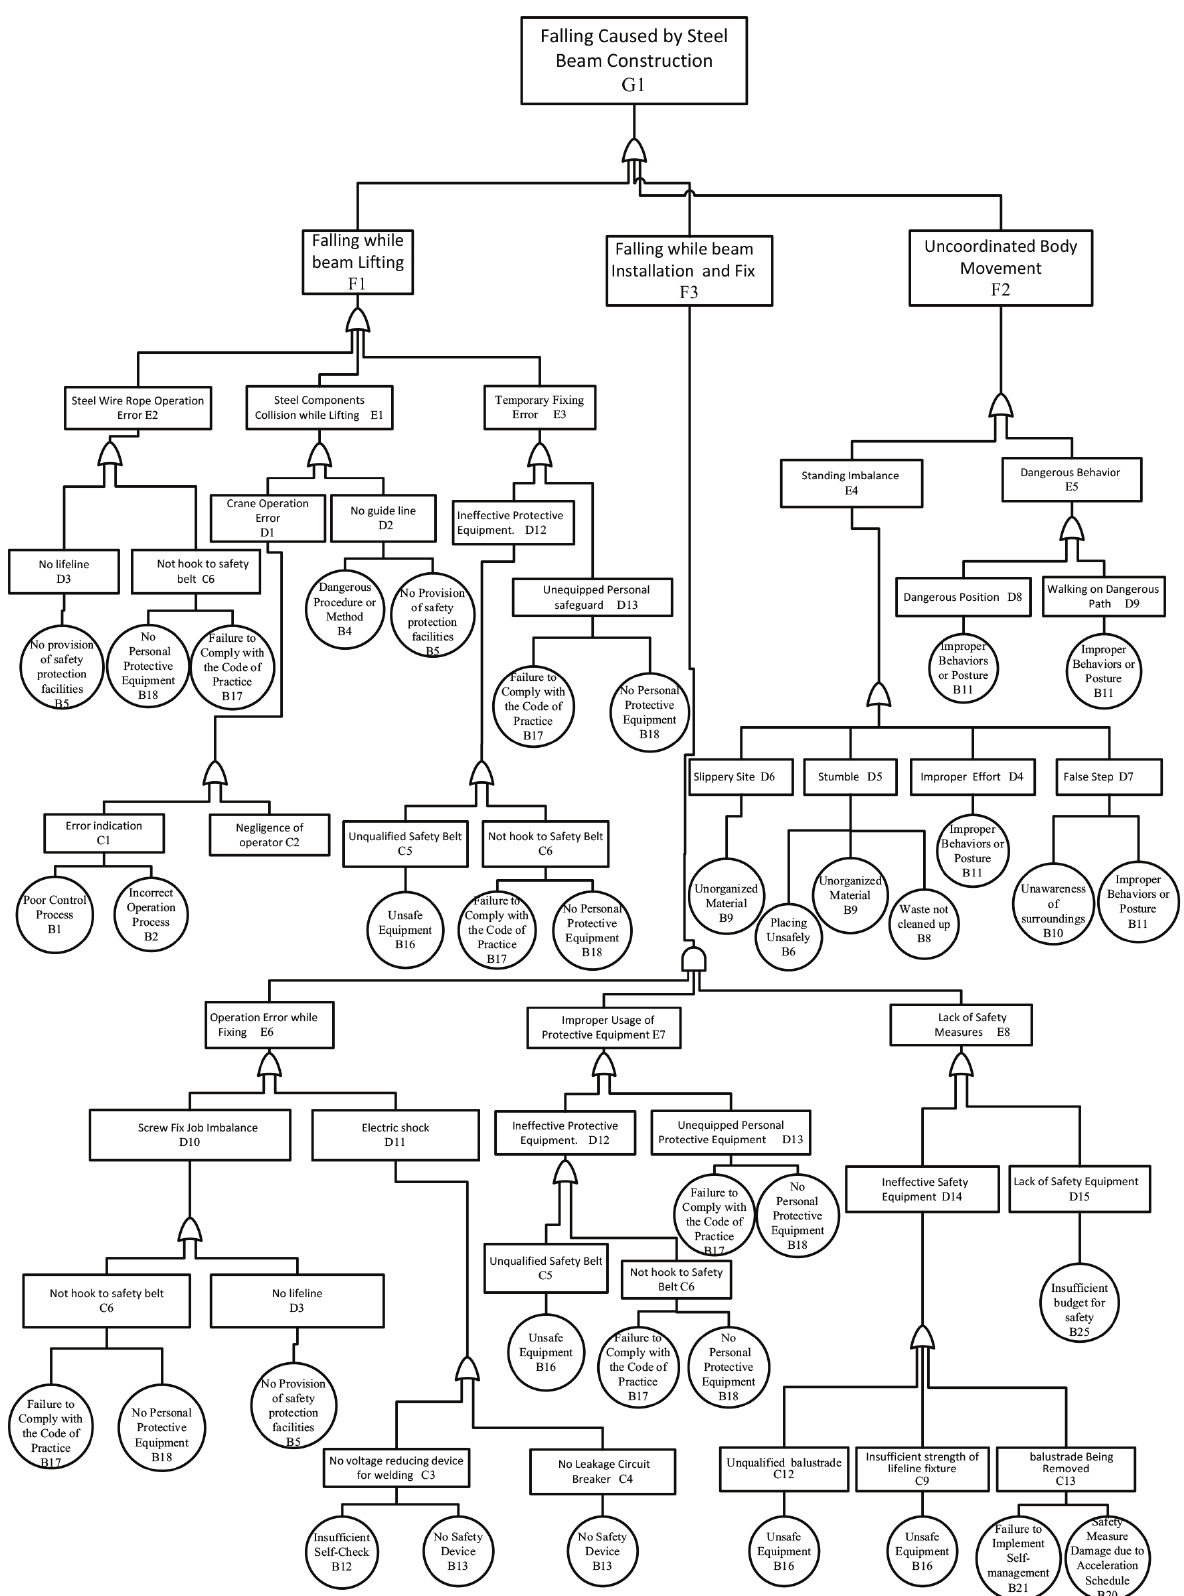
Fig. 2. FT of falling accidents at beam erection of SC